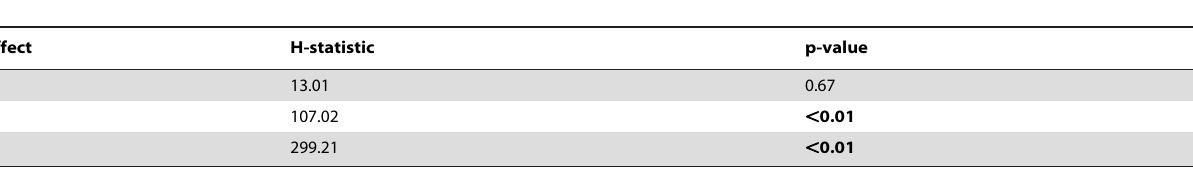
Table 2. Results from the Kruskal-Wallis tests showing the relative variability of each design variable on the predicted performance: keyboard radius of curvature (R), keyboard orientation with respect to vertical (O), and keyboard vertical location on the screen (L).